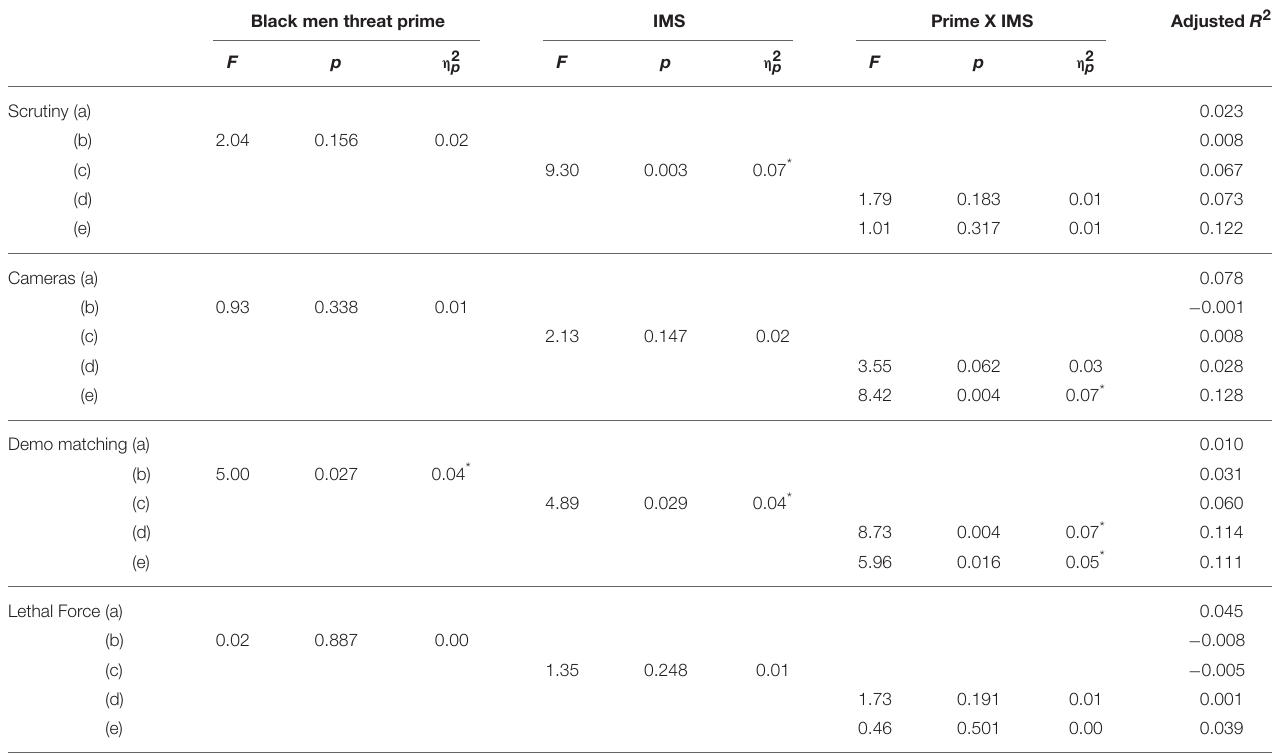
TABLE 5 | Results of Study 3 multivariate analysis of covariance using manipulated threat associated with Black men to predict support for policing policy reform